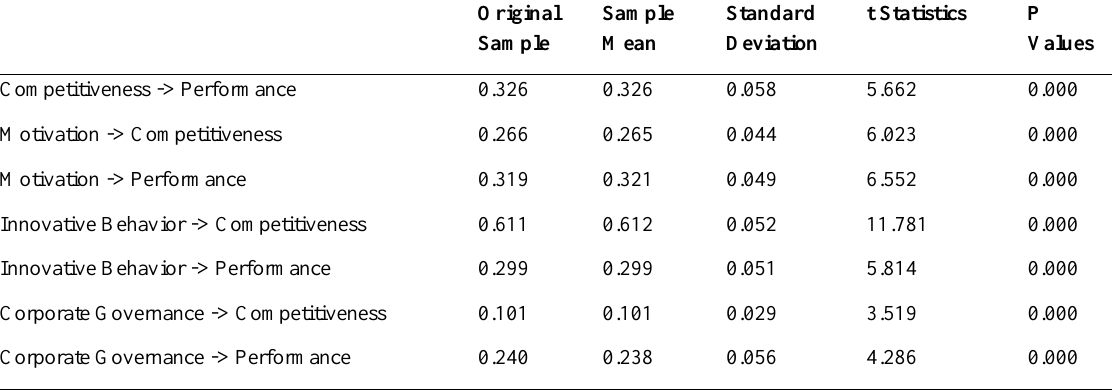
Table 4: Total Effects Between